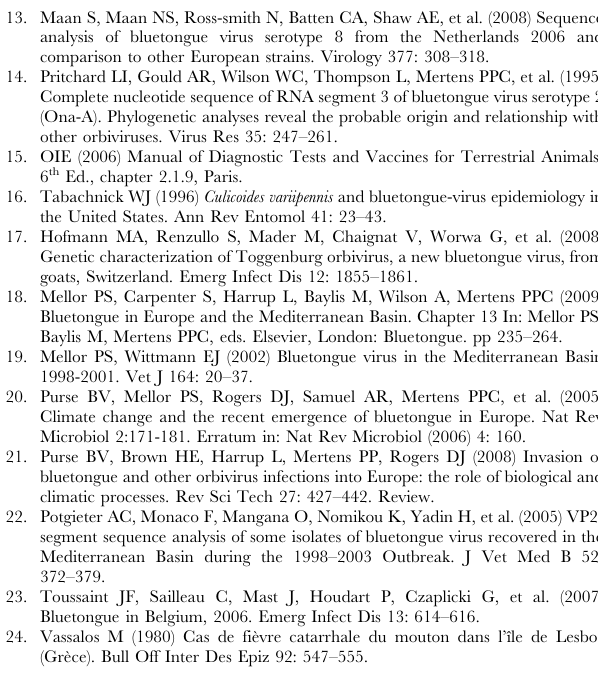
reference collection number. The numbers indicated on branches are non-parametric bootstrap (NPB) probabilities and only values with P . 0.6 are